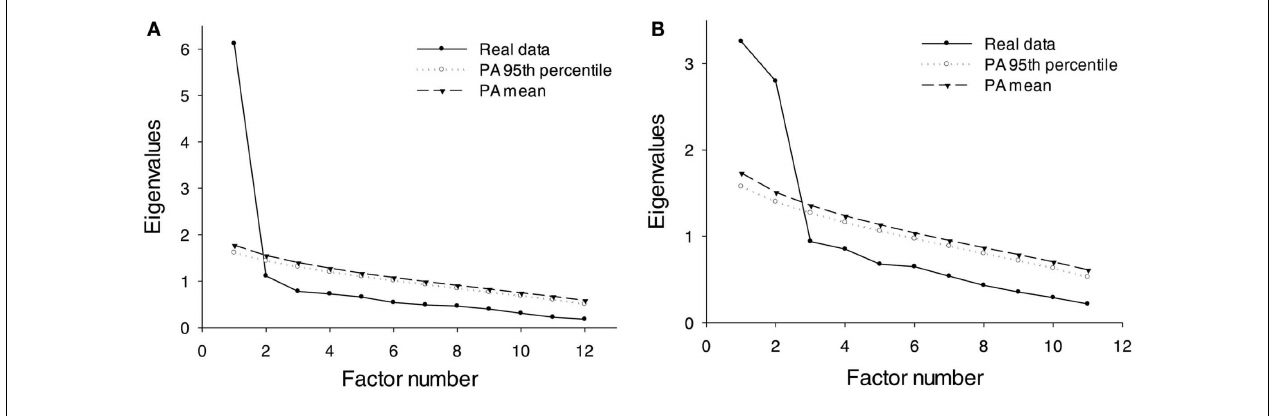
FIGURE 1 | Scree plots for the principal component analyses. (A,B) respectively represent the eigenvalues for the principal component analyses performed on the DDFS and FST items for the real data sets, as well as the mean eigenvalues and upper